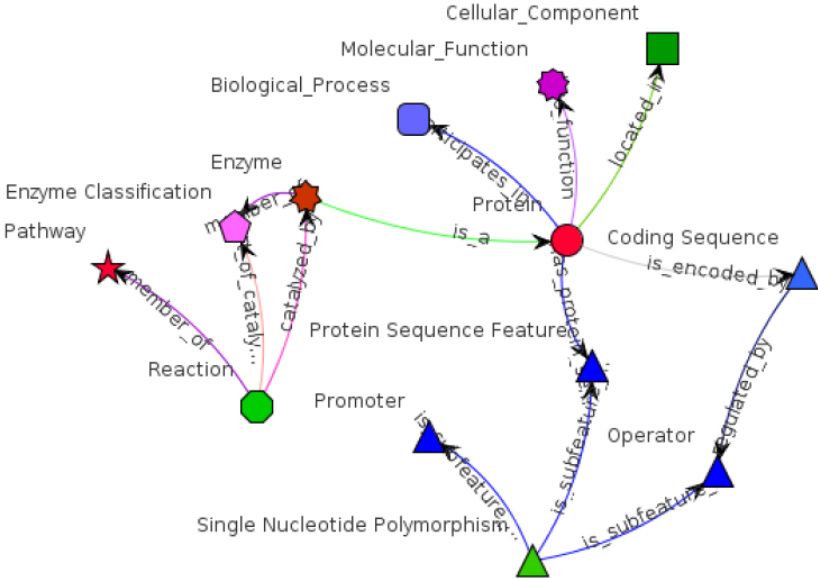
Figure 3. An overview of the concept classes and relation types contained within the graph produced by the BacillOndex dataset showing the relationship between concept